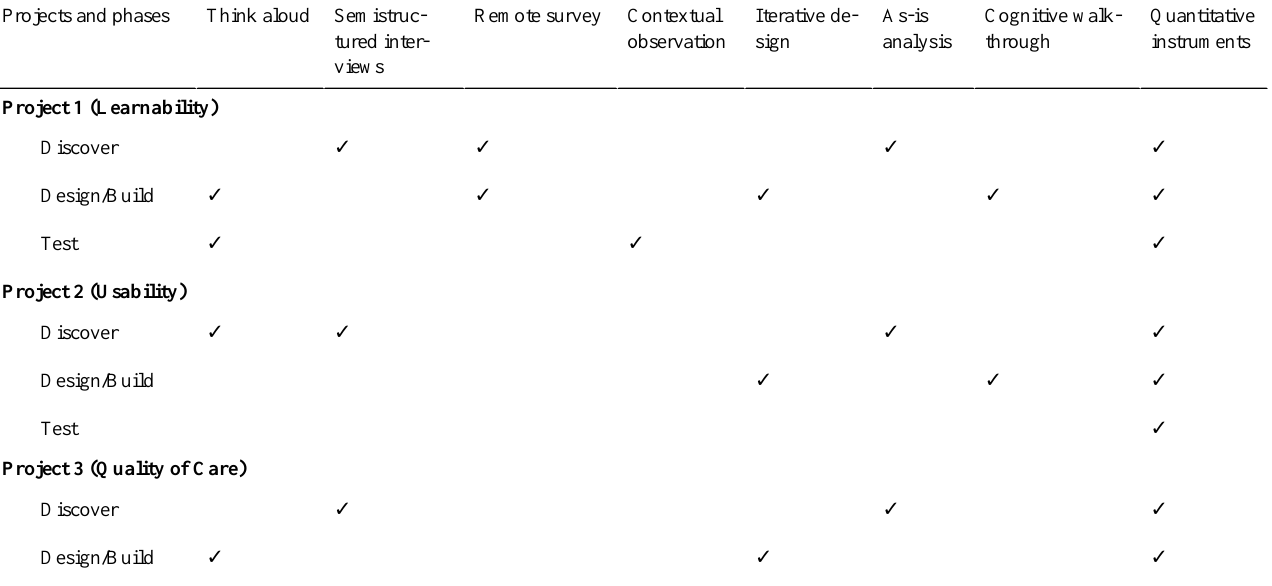
Table 3. Planned data collection across projects and DDBT (Discover, Design/Build, and Test)